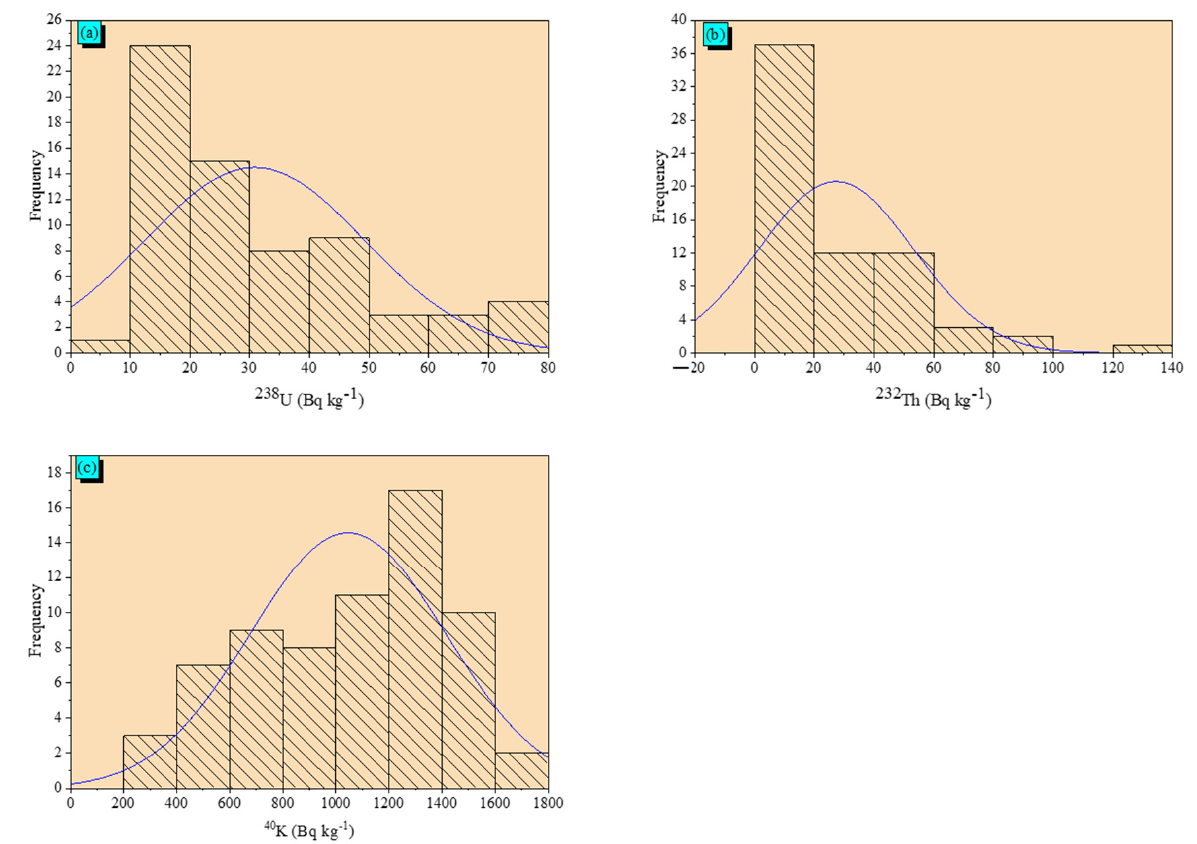
Figure 4. Frequency distribution of ( a ) 238 U, ( b ) 232 Th, and ( c ) 40 K activity concentrations in studied area. Table 3. Comparison of 238 U, 232 Th and 40 K activity concentration in the Hafafit Area area with numerous world